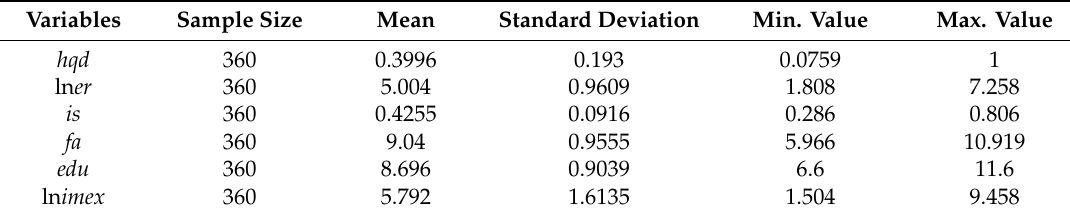
Table 3. Descriptive statistical